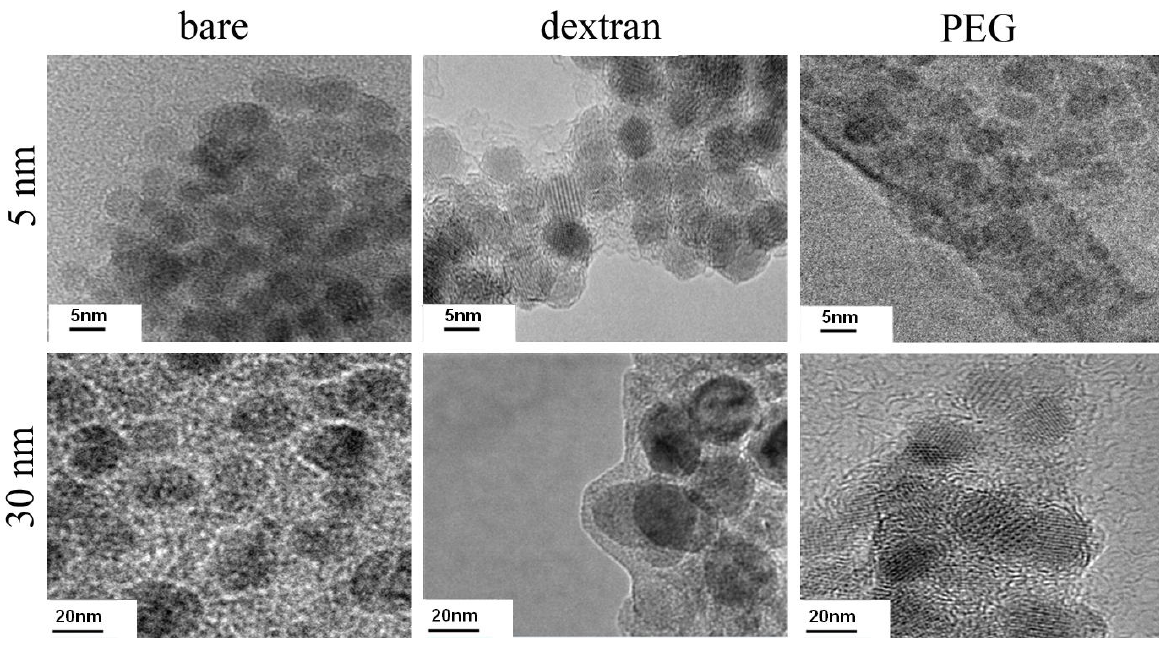
Figure 1. 5 and 30 nm nanoparticles were coated with dextran and polymer polyethylene glycol (PEG). Nanoparticle samples were sonicated for 1 h with either dextran or m-PEG-silane and imaged by